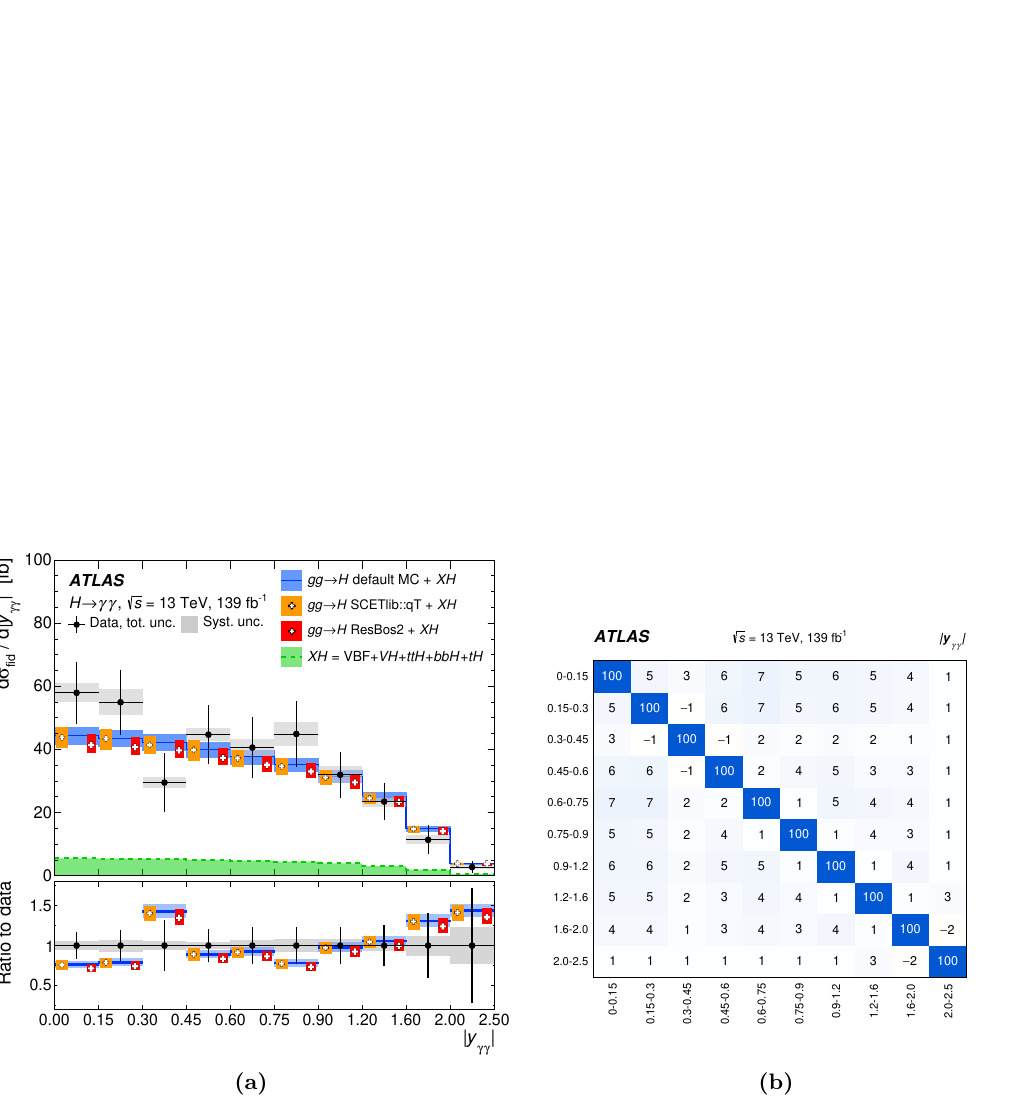
Figure 26. (a) Particle-level fiducial differential cross-sections times branching ratio for the diphoton rapidity | y together with (b) the corresponding correlation γγ |